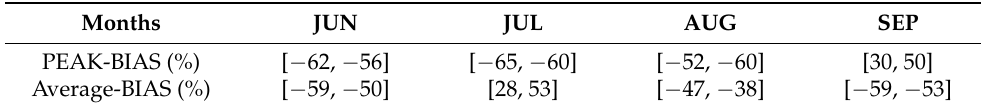
Figure 10. Different peak timing rainfall patterns analysis. Table 7. PEAK BIAS and Average BIAS for E1, E3, E4, E5, and E6.